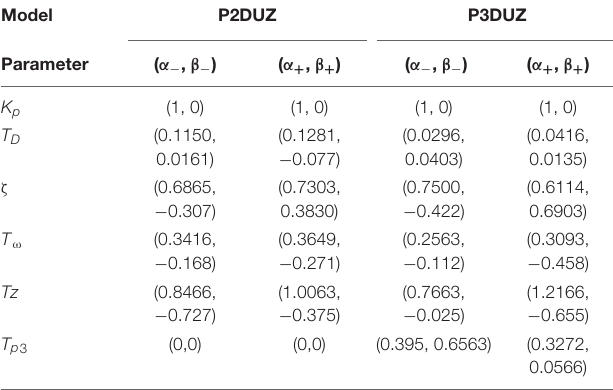
jump from a baseline of 100